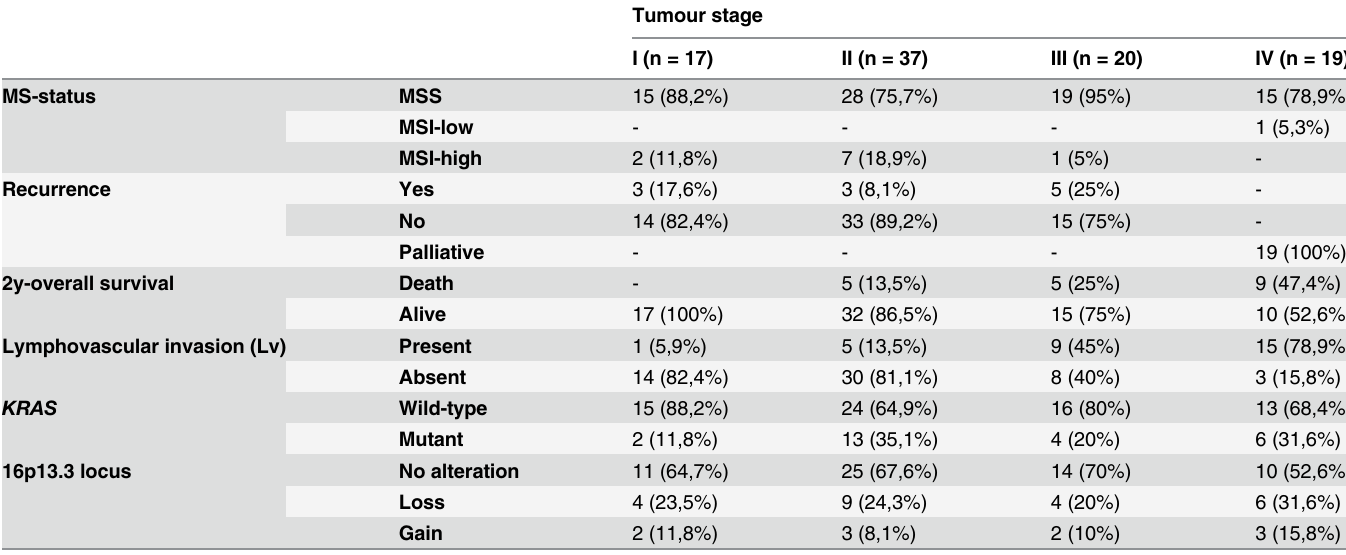
Table 1. Patient characteristics of the patient population with at least 50% of tumour cells (n = 93). An extended table of patient characteristics can be found in S1 and S2